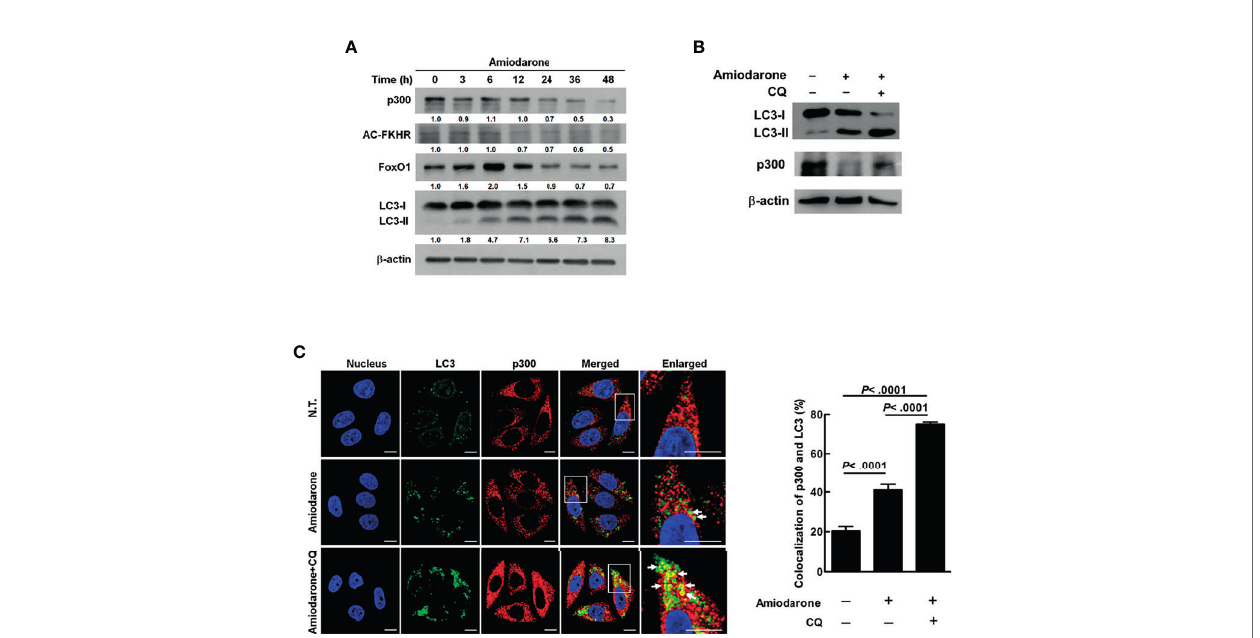
FIGURE 3 | Amiodarone-induced autophagic machinery degrades p300 protein, activates FoxO1, and increases miR-449a expression. (A) SW480 cells were treated withamiodarone (10 m M) for 48 h. The levelsof p300, AC-FKHR, FoxO1, and LC3 were measured using anti-p300, anti-AC-FKHR, anti-FoxO1, and anti-LC3 antibodyby immunoblotting. b -actinwas used as the internal control. (B) Cellswere treated with amiodarone (10 m M) for 48 h. In the CQ group, the cellswere treatedwithamiodarone (10 m M) together with CQ (50 m M) for 48 h. The p300 and LC3 levelswere determined by immunoblotting using speci fi c antibodies. b -actin was used as the internalcontrol. (C) Colocalization of p300 andLC3 proteins were demonstrated by anti-p300 conjugated with rodamin(red) and anti-LC3 conjugatedwithFITC (green) antibody, respectively. The fl uorescent change of the cellswas investigated under a multi-photon confocal microscope. Quanti fi cation of colocalization was performedby counting 30 cells. The p -values were determinedbyStudent ’ s t -test